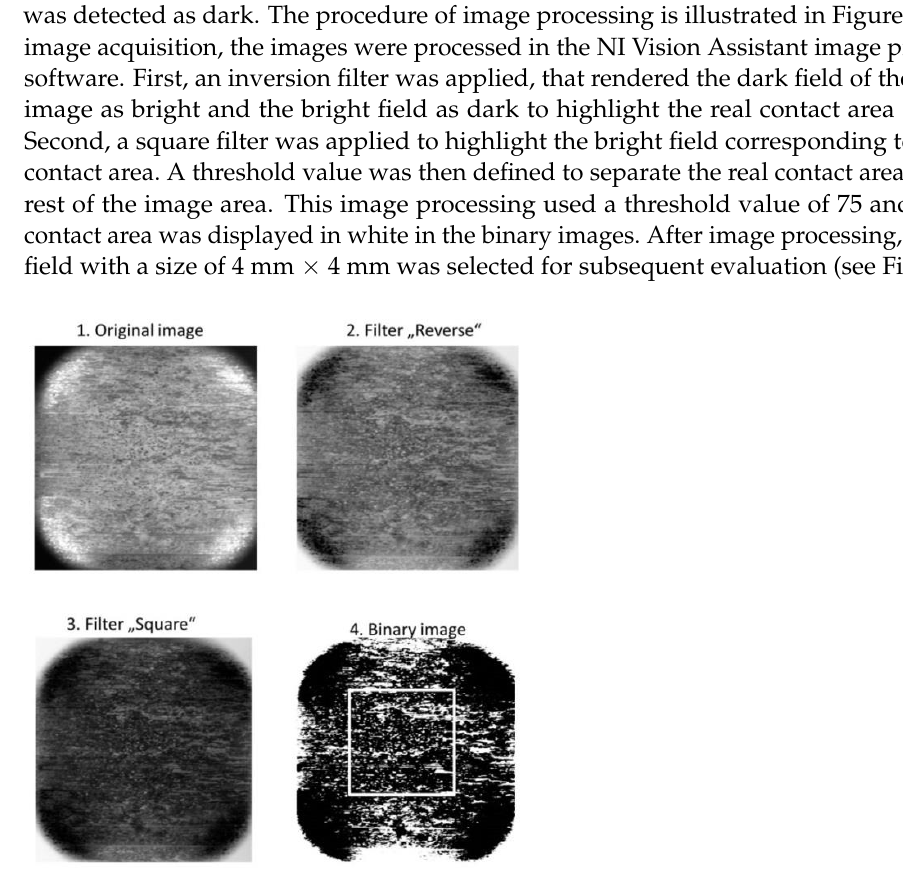
Figure 17. Real contact area (white) in a region of 4 mm × 4 mm of the test with 7.5 MPa contact stress and 50 mm/s sliding speed; ( a ) DC06 with 0% pre-straining; ( b ) DC06 with 5% pre-straining; ( c ) DC06 with 10% pre-straining; ( d ) HX340LAD with 0% pre-straining; ( e ) HX340LAD with 5% pre-straining; ( f ) HX340LAD with 100% pre-straining. By comparing the behavior of the two types of materials after identical pre-straining (Figure 17b,e) it can be found that the distribution of the real contact was more homog- enous for HX340LAD than for DC06 and the real contact area was also higher. To quan- tify the processed images in Figure 17, the portion of real contact area was calculated by analyzing the portion of “bright” pixels relative to the total number of pixels of the im- ages. The parameter “portion: real contact area” is calculated in MATLAB with the fol- lowing equation: Portion: real contact area = Sum: bright pixel overall amount of pixel (4) Figures 18 and 19 show the portion of the real contact area of the friction test after different sheet metal pre-straining. For the DC06, it can be seen that the contact on the